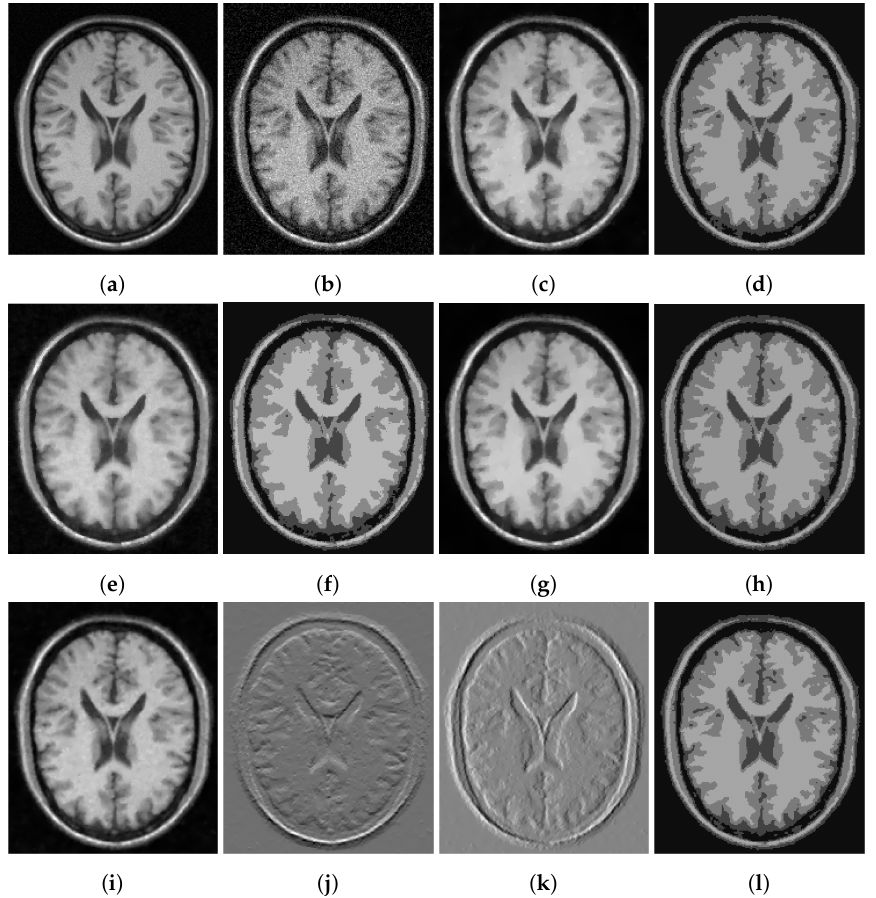
Figure 3. MRI segmentation: ( a ) Clean image. ( b ) Noisy image used as input to the models. ( c ) Output of CCZ. ( d ) CCZ after thresholding. ( e ) Output of CNC. ( f ) CNC after thresholding. ( g ) Output of T-ROF. ( h ) T-ROF after thresholding. ( i ) Output g of our model. ( j ) Output G x of our model. ( k ) Output G y of our model. ( l ) Ours after thresholding.